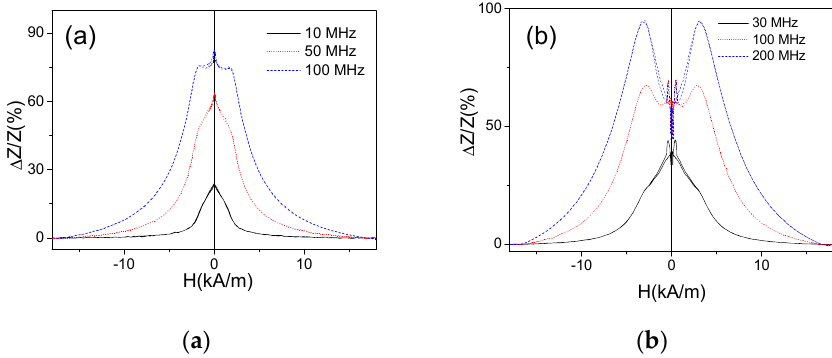
Figure 16. Δ Z/Z ( H ) dependencies observed in stress-annealed at T ann = 350 °C (for 60 min and Figure 16. ∆ Z / Z ( H ) dependencies observed in stress-annealed at T ann = 350 ◦ C (for 60 min and σ = 190 MPa) ( a ) and at T = 300 ◦ C (for 60 min and σ = 900 MPa) ( b ) Fe σ a = 190 MPa) ( a ) and at T ann = 300 °C (for 60 min and σ a = 900 MPa) ( b ) Fe 75 B 9 Si 12 C 4 microwires. a a ann 75 B 9 Si 12 C 4